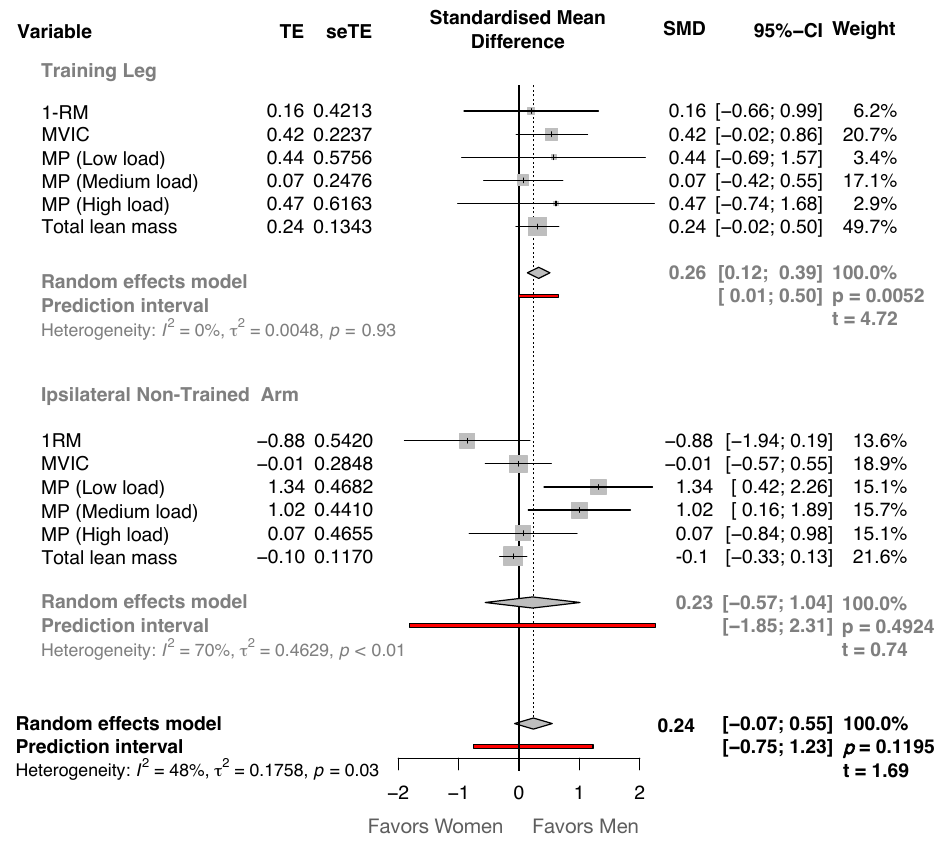
Figure 1. Forest plot showing the difference in the standardized mean differences between men (right side of the vertical black line) and women (left side of the vertical black line) in the training leg and in the non-trained